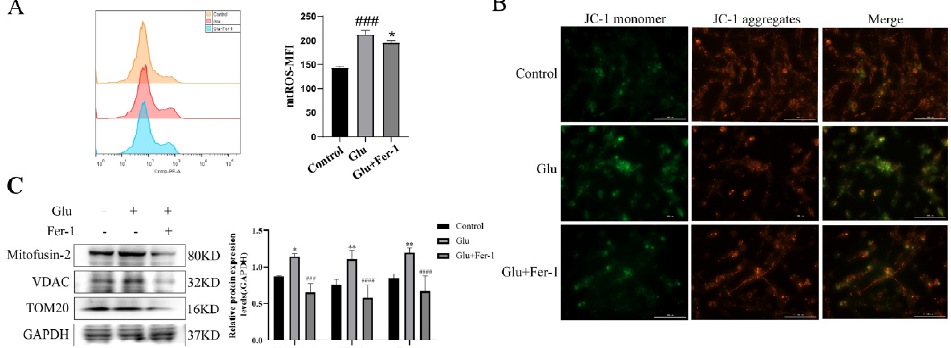
Figure 6. Glutamate stimulation of HT22 cells causes mitochondrial damage. For all experiments, glutamate: 10 mM, Fer-1: 5 µ M, treatment time: 24 h. ( A ) HT22 cells were treated with indicated drugs for 24 h, and the level of mtROS was detected by flow cytometry with mtROSTM 580 (n = 3). ### p < 0.001 compared with the normal group; glutamate combined with Fer-1 group compared with glutamate group, * p < 0.05. ( B ) JC-1 kit was used to evaluate the effect of glutamate stimulation on MMP in HT22 cells. Red fluorescence: aggregates; green fluorescence: monomer; yellow fluorescence: combined. Scale bar is 100 μ m. ( C ) The expression levels of Mitofusin2, VDAC and TOM20 in different groups were detected by Western blotting, and to quantify and analyze. */**: It indicates that the glutamate-treated group compared to the blank control group, * p < 0.05, ** p < 0.01. ###/####: It indicates that pretreatment of the glutamate group with Fer-1 compared to that without Fer-1, ### p < 0.001, #### p < 0.0001. Two-way ANOVA multiple comparisons were performed between